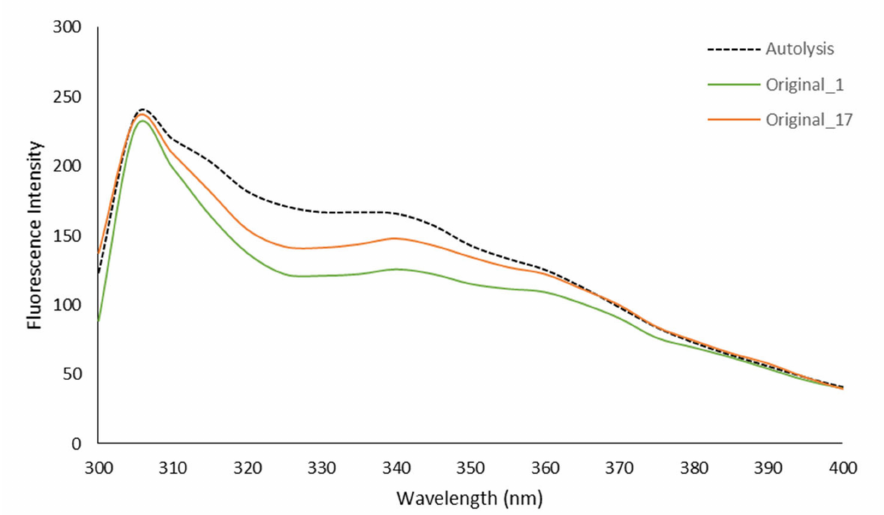
Figure 3. Fluorescence emission spectra of autolysis supernatant (dashed line) and iron–peptide complexes at 1 and 17 g/L protein concentrations (solid green and orange lines, respectively). Excitation wavelength = 280 nm; emission wavelength = 300 to 400